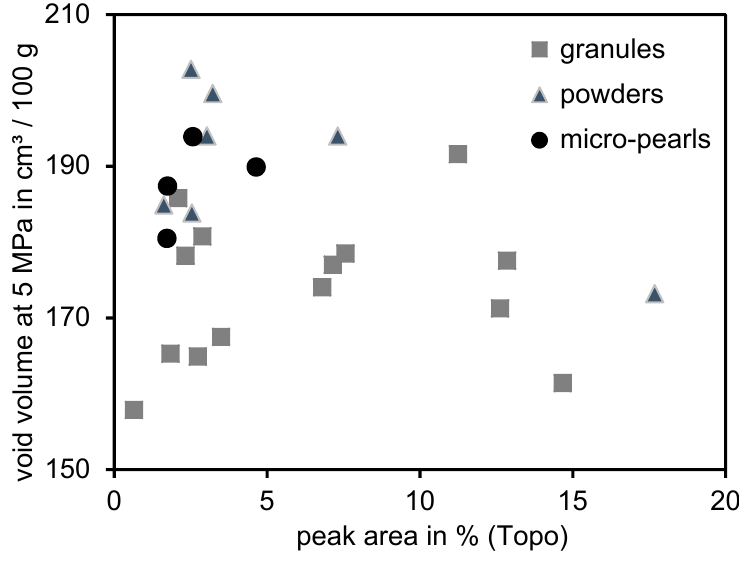
Figure 4. Correlation between the void volume measurements and the peak area obtained by means of the topography Test .